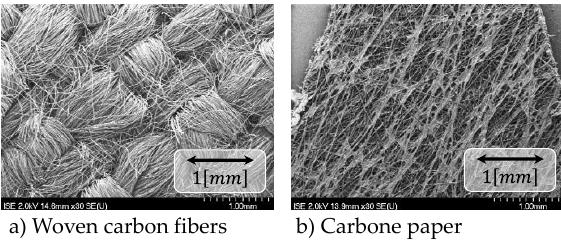
ff usion layer (GDL) technologies